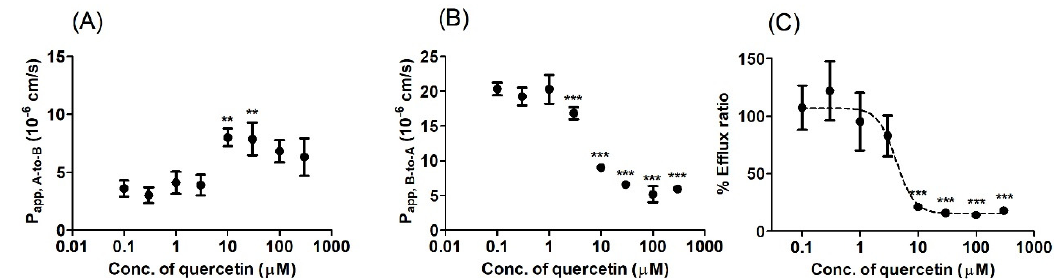
Figure 4. Bi-directional transport of prazosin in BCRP-overexpressing Madin-Darby Canine Kidney-II (MDCKII/BCRP) cells under various concentrations of quercetin (0.1–300 μ M). ( A ) Apical-to-basolateral apparent permeability coefficient (P app , A-to-B ) and ( B ) basolateral-to-apical apparent permeability coefficient (P app , B-to-A ) of prazosin. ( C ) The percentage of the control efflux ratio (%ER, compared to the value without inhibitor) is shown together with the best-fit values generated from the nonlinear regression analysis based on Equation (2). Asterisks indicate statistical differences (* P < 0.05; ** P < 0.01; and *** P < 0.001) from the control (i.e., without quercetin) according to one-way ANOVA, followed by Tukey’s post hoc test. Data are presented as the mean ± SD of triplicate runs. Data are presented as the mean ± SD of triplicate runs.